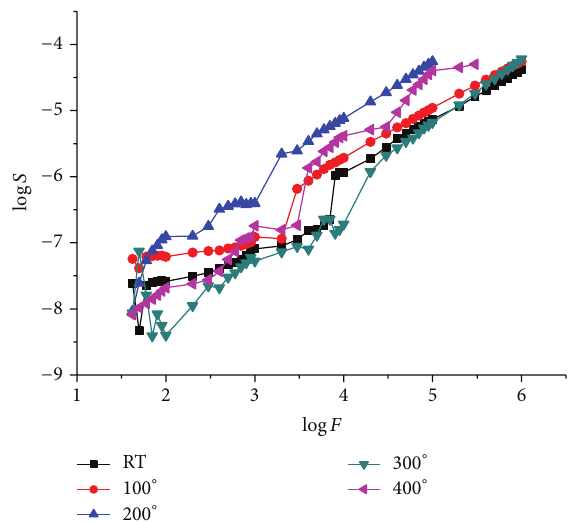
Figure 5: Comparison of conductivity graph versus log 𝜎 for the results ranging from room temperature to 400 ∘